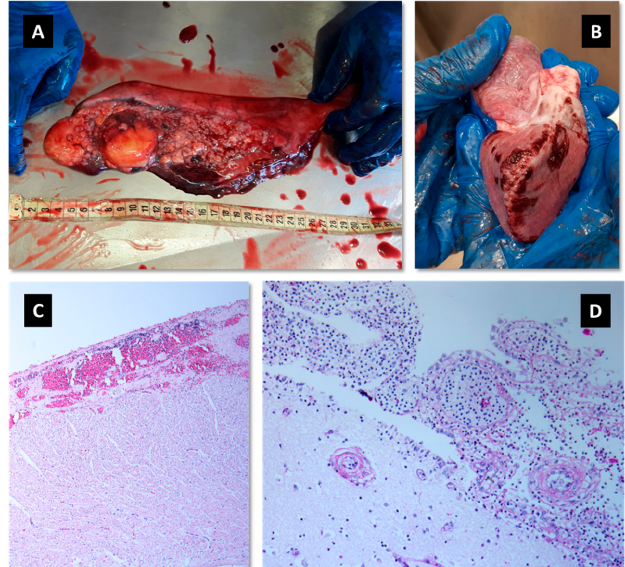
Figure 1. ( A ) Reproductive system: multifocal pyogranulomatos, irregular lumpy and firm texture, and extensive hemorrhages. ( B ) Heart: multifocal to coalescing epicardial hemorrhages and mild emphysema of the atrium. ( C ) Heart: reactive mesothel with hyperthrophy of the mesothelial cells resembling cuboidal epithelium, extensive hemorrhages and inflammation with mononuclear and polymorphonuclear cells. Inflammation is also present in the blood vessels’ wall (vasculitis) with some level of liquefying necrosis (hematoxylin and eosin, 100 magnification). ( D ) Brain: meningoencephalitis; fibrin and white blood cells in the blood vessels of the meninges. Perivascular cu ffi ng with vascular liquefying necrosis (hematoxylin and eosin, 400